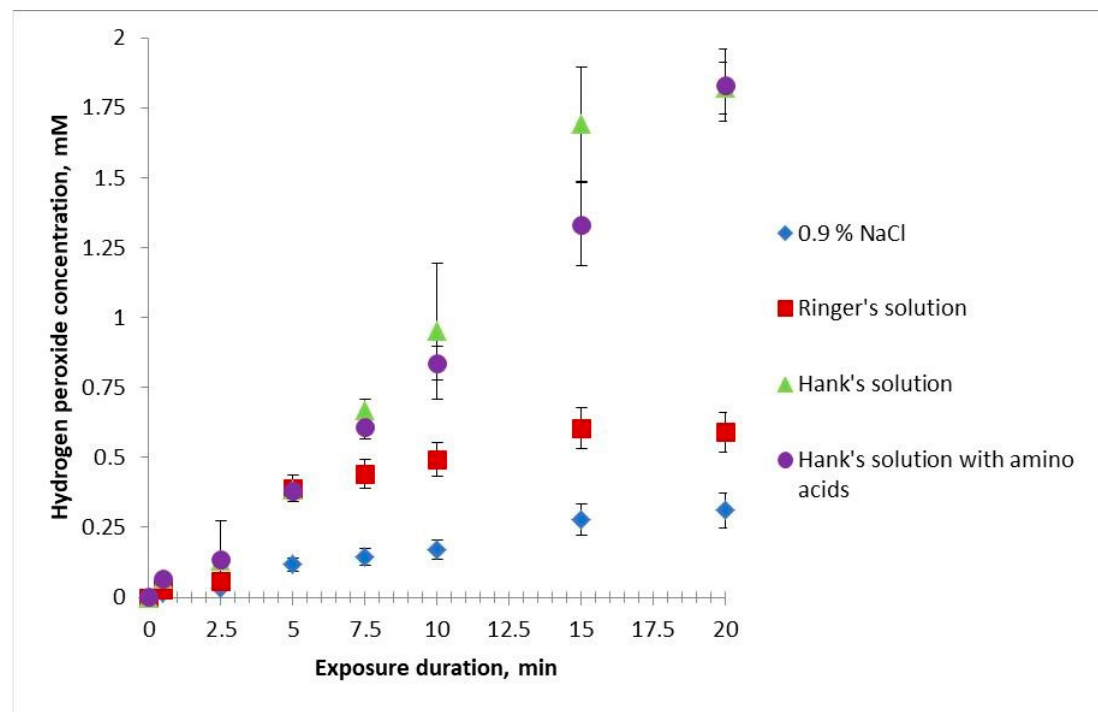
Figure 2. Dependence of the concentration of hydrogen peroxide in the studied solutions on the times of their treatment with cold plasma.